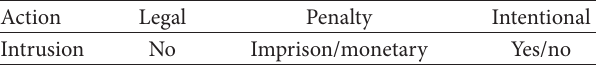
Table 2: The punishment criteria of hacking in Korea. Action Legal Penalty Intentional Intrusion No Imprison/monetary